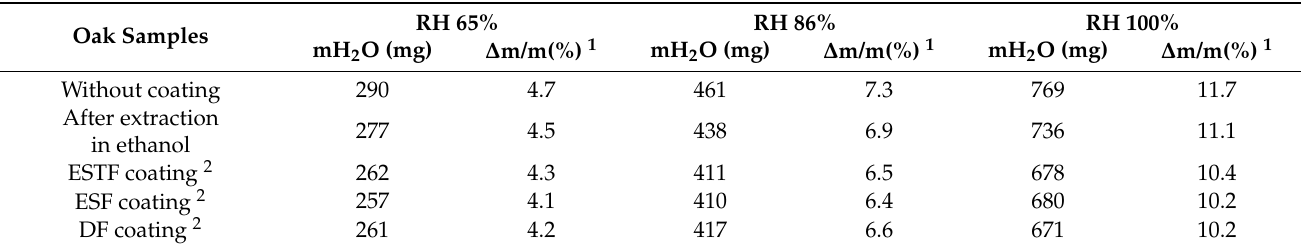
Figure 10. Water vapor absorption per unit of weight (%) over time at different RH values for oak sample, oak sample after ethanol extraction, and oak samples after coating with ESTF, ESF, or DF. Table 7. Total mass of water absorbed at different RH values and mass per unit of weight of the sample (%). Oak Samples